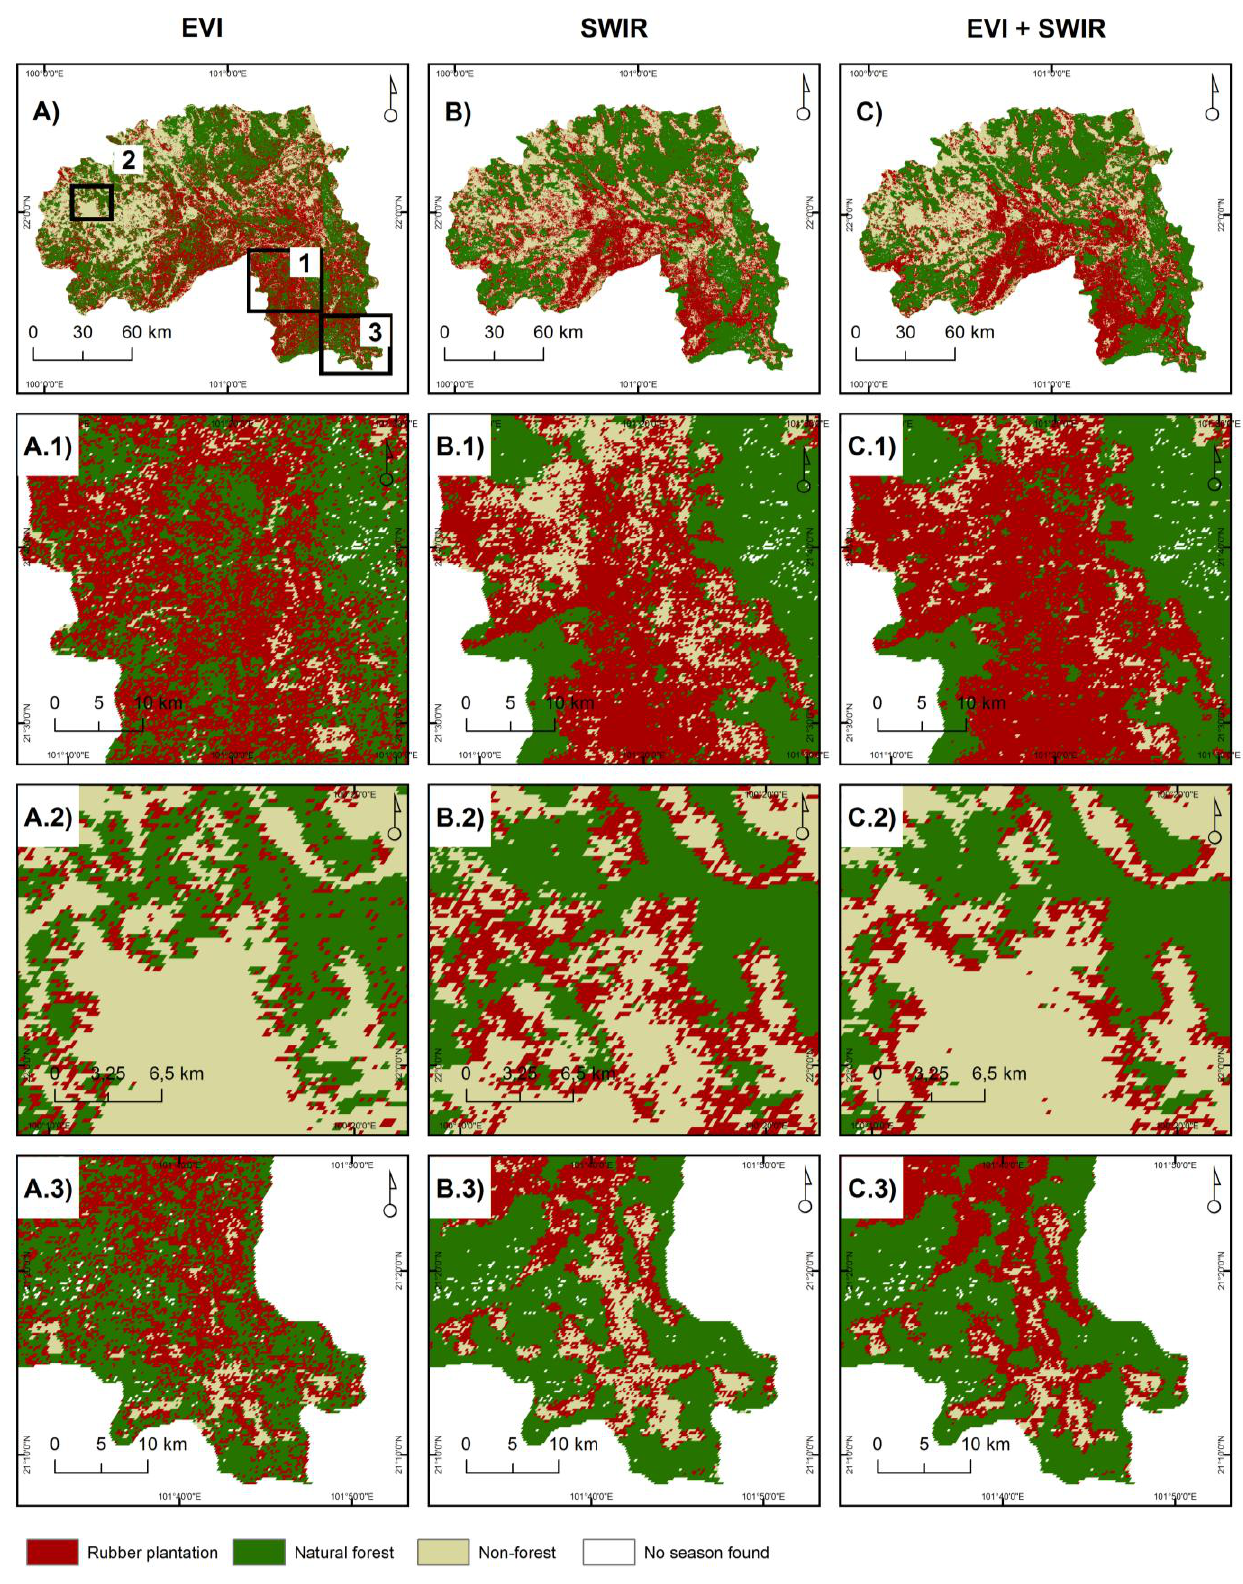
Figure 4. ( A ). (A.1–A.3) Enhanced Vegetation Index (EVI) classification map with details. ( B ). (B.1–B.3) short-wave infrared (SWIR) classification map with details. ( C ). (C.1–C.3) EVI-SWIR classification map with